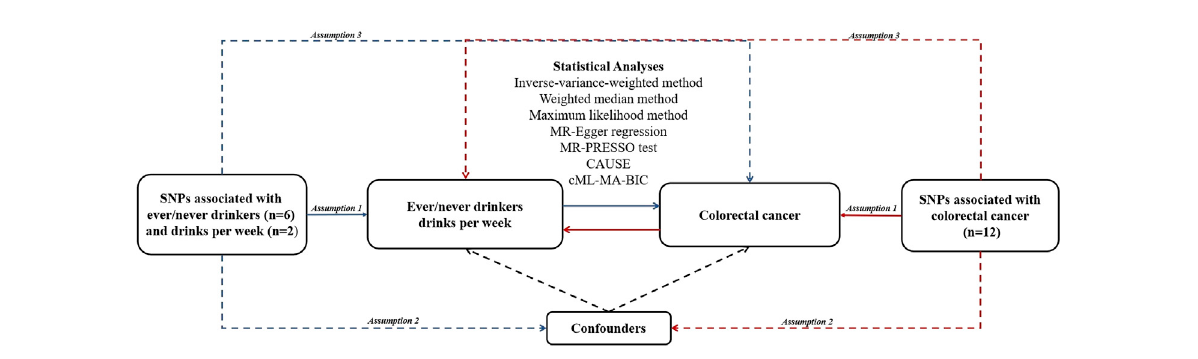
FIGURE 1 An overview of study design. Blue lines represent the assumptions and estimates of alcohol consumption on CRC risk, and red lines represent the assumptions and estimates of CRC on alcohol consumption risk in the reverse MR study. Abbreviations:CAUSE, Causal Analysis Using Summary Effect estimates; cML-MA-BIC, constrained maximum likelihood and model averaging and Bayesian information criterion; MR, Mendelian randomization; MR-PRESSO, MR-Pleiotropy RESidual Sum and Outlier; SNP, single nucleotide